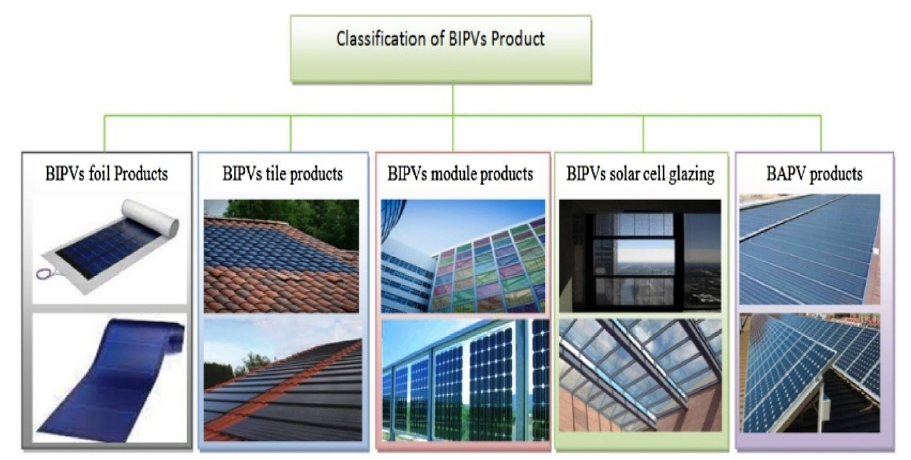
Figure 5. Classification of BIPV products